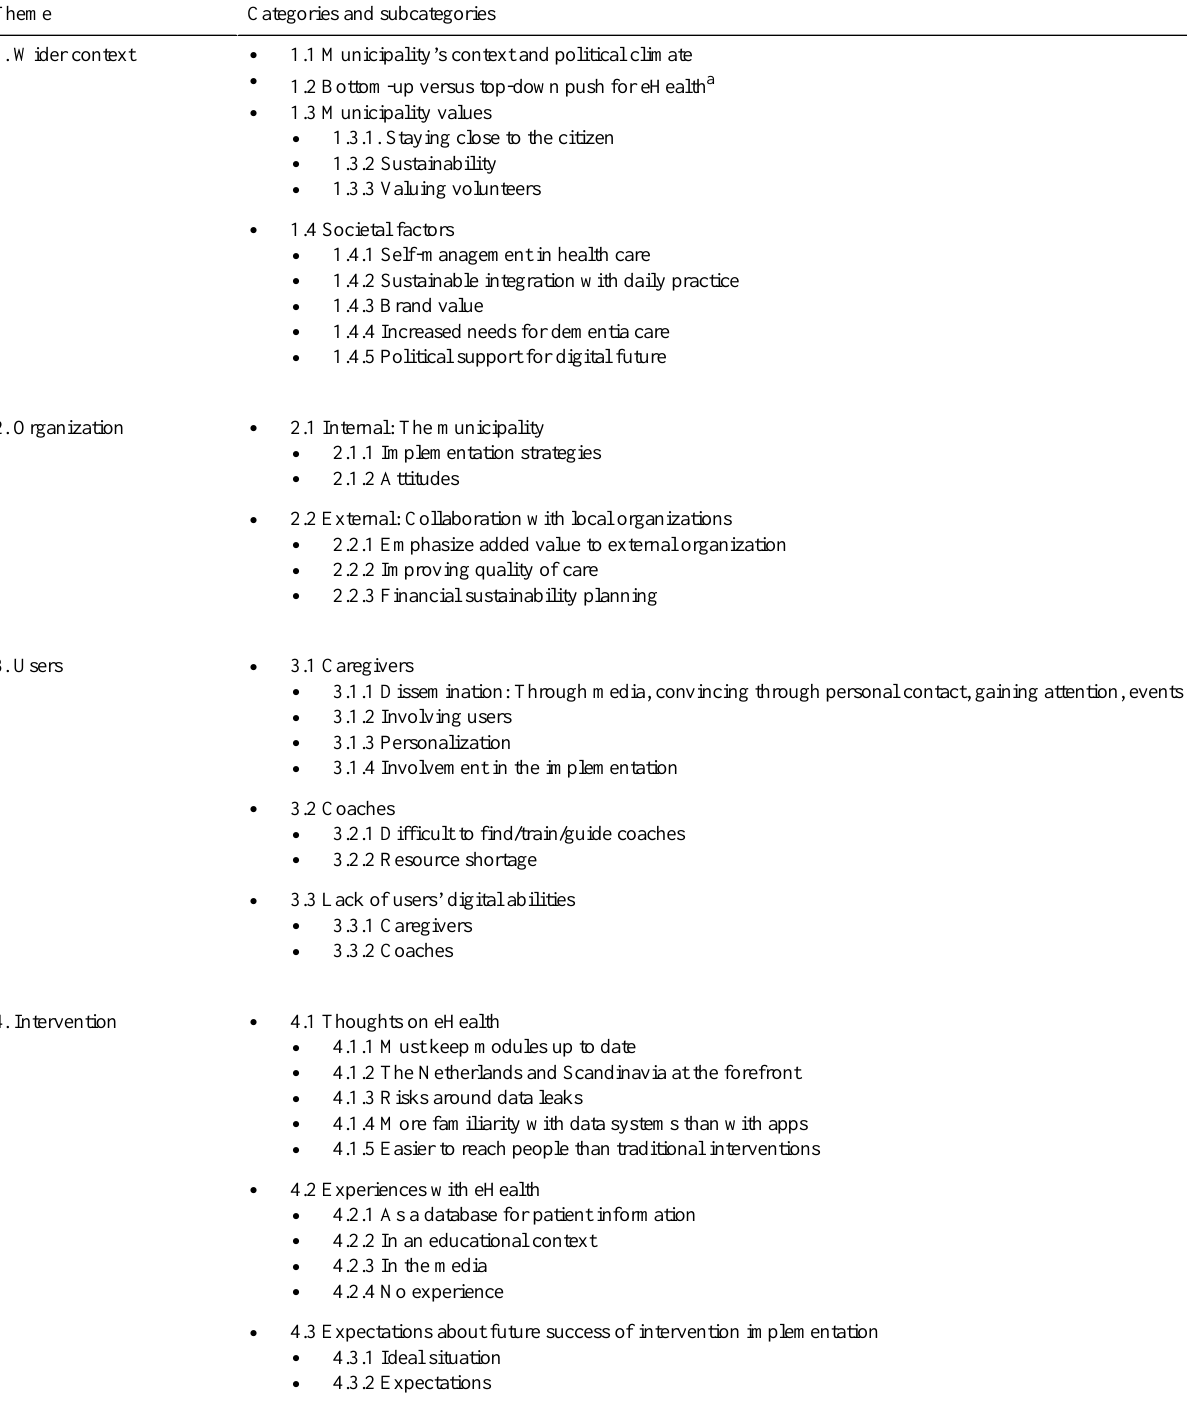
Table 2. Interview themes and categories. Categories and